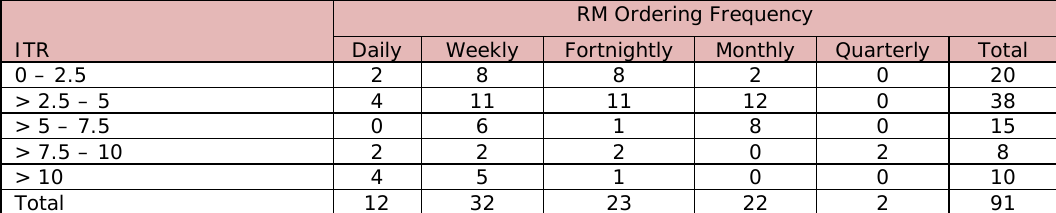
Table 10. “Raw Material Ordering Frequencies and